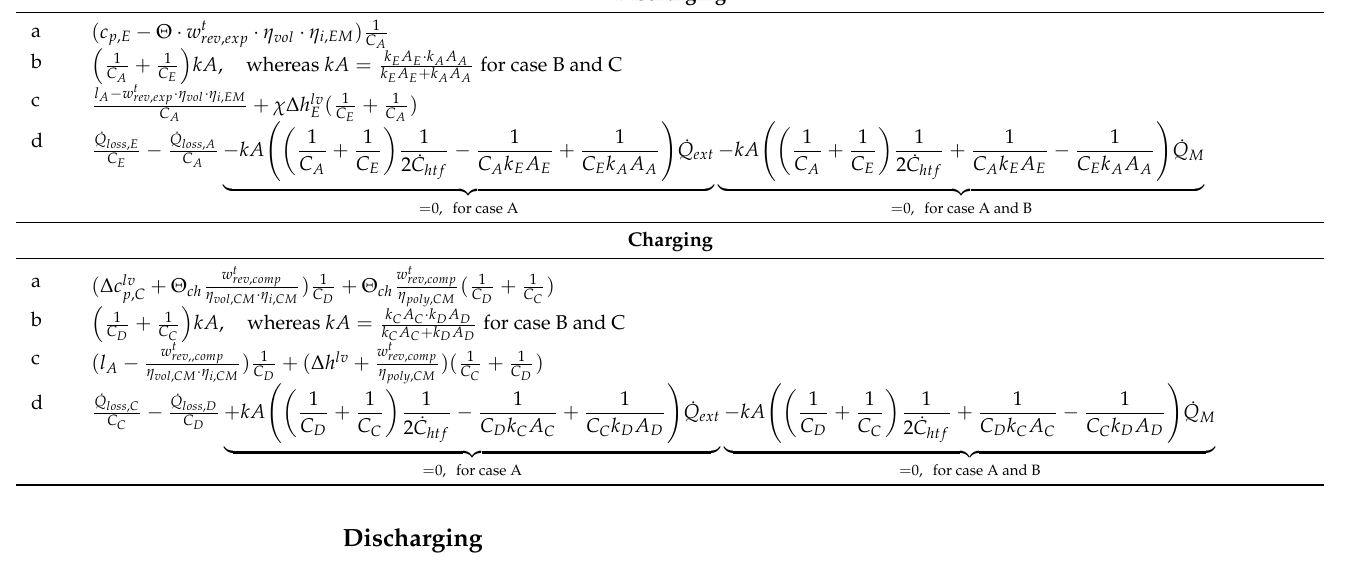
Table 1. Variable coefficients of differential Equation (9).